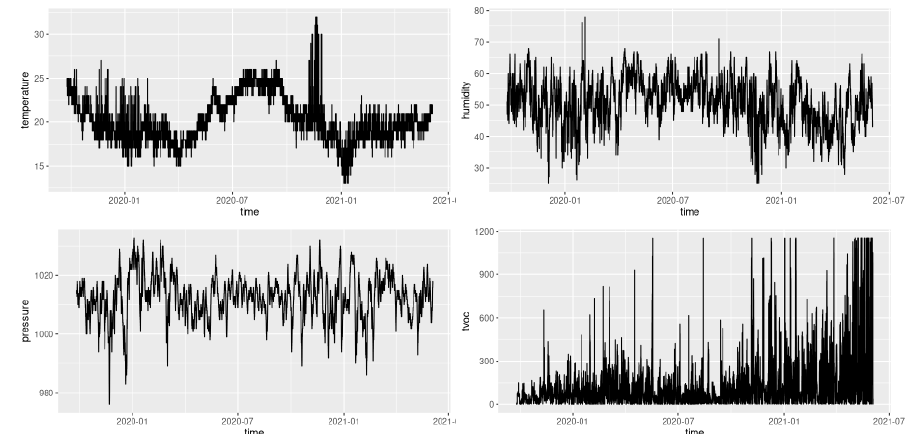
Figure 2. Course of the remaining variables over time.